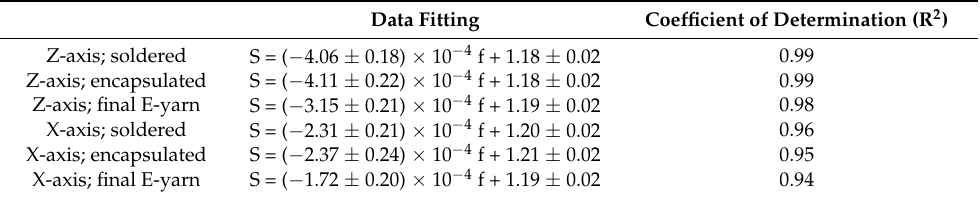
Table 1. Fitting parameters for the frequency response experiments at the different stages of the manufacturing process. S is the sensor response, f is the frequency.